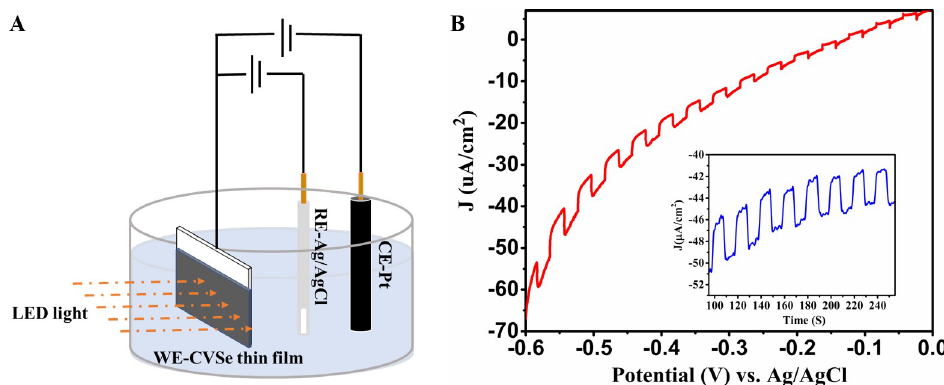
Fig 6. (A) Scheme of CVSe based three-electrodes photoelectrochemical cell. (B) Current-voltage (JV) curve of the CVSe thin film in KCl aqueous solution; insert graph is photocurrent response of the CVSe thin film in KCl aqueous solution at -550